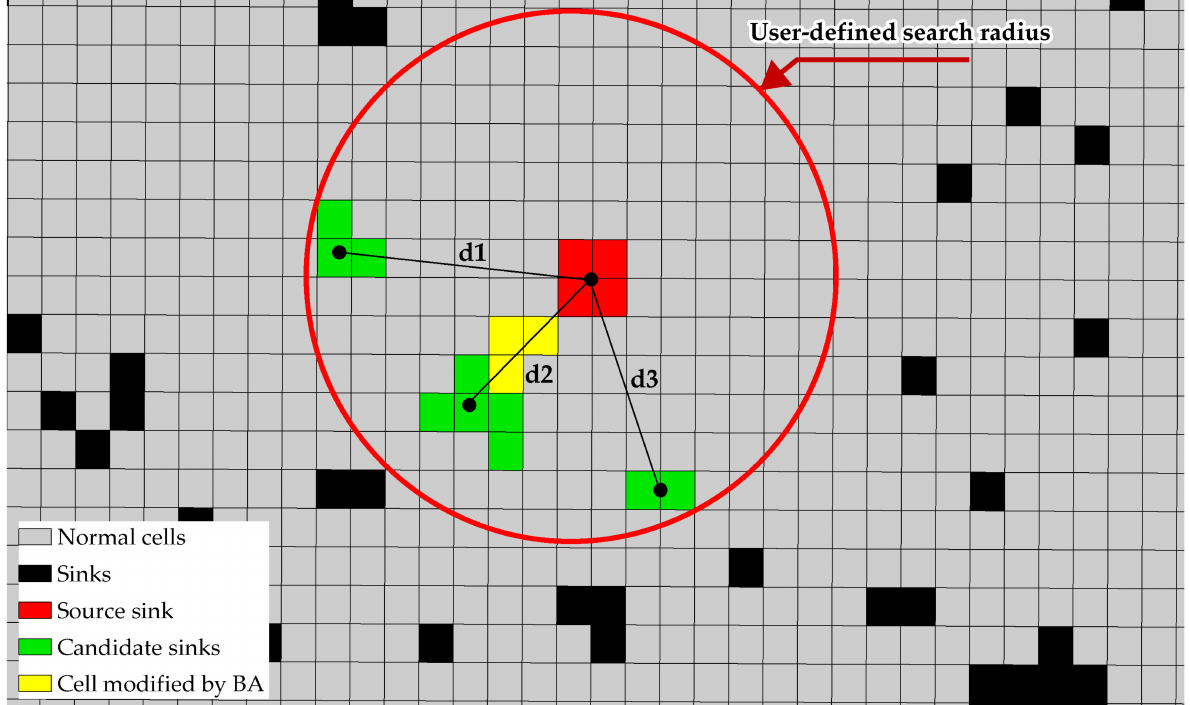
Figure 4. Schematic diagram of the breaching algorithm (BA) method for fixing sinks in a DEM associated with